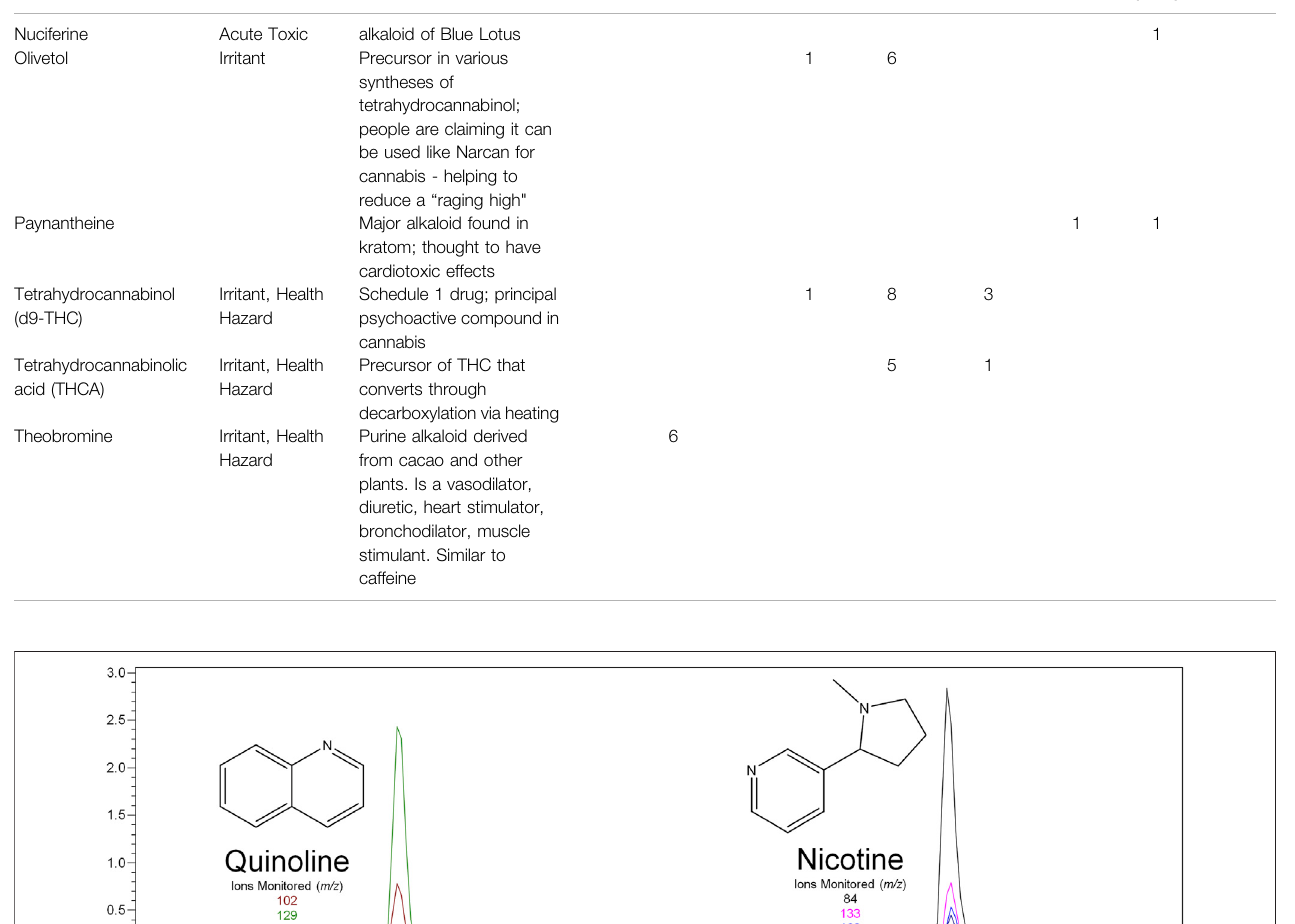
Frontiers in Chemistry |